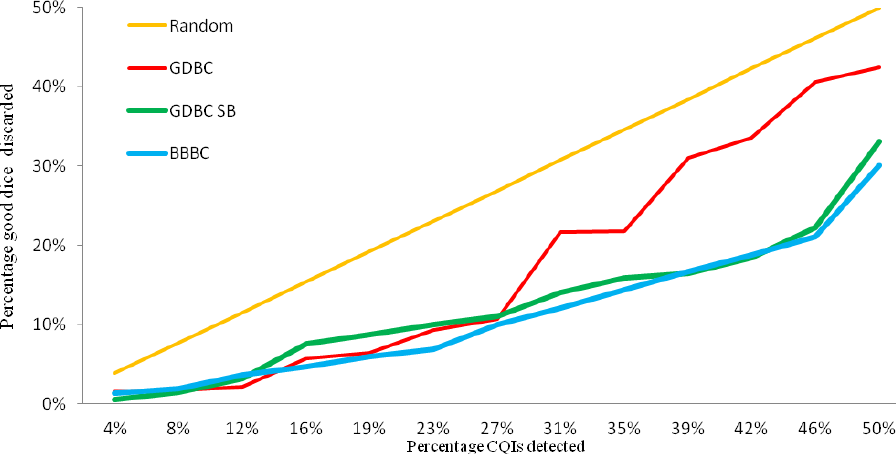
Figure 7. Spatial algorithms